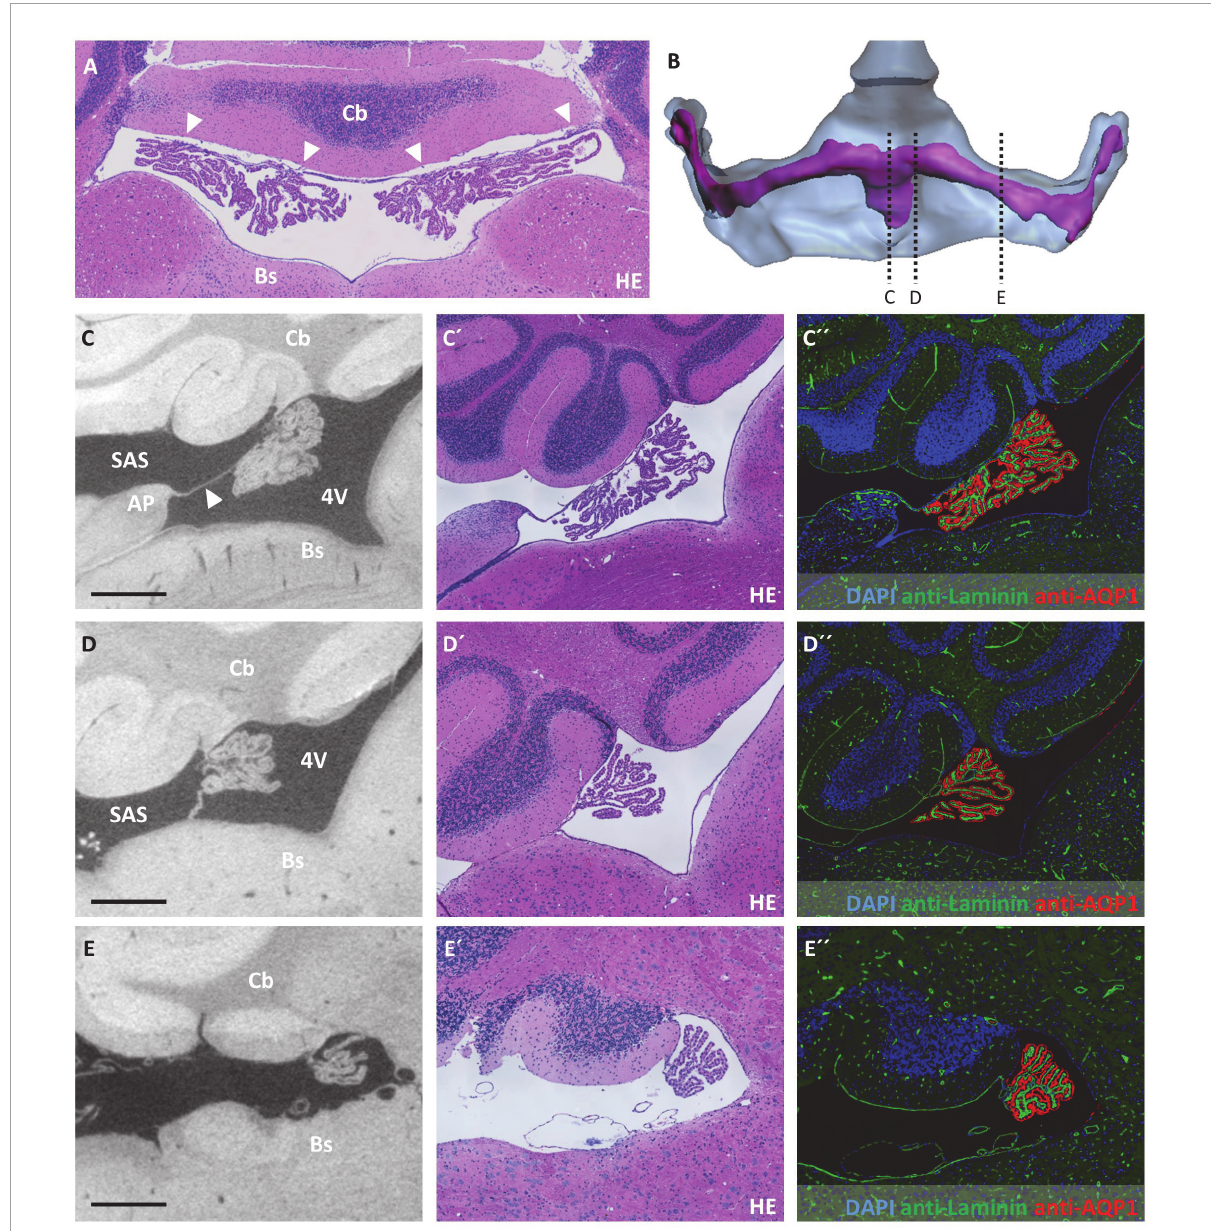
FIGURE5 Attachment regions of the choroid plexus in the fourth ventricle and opening of the fourth ventricle to the subarachnoid space. (A) Horizontal section of the fourth ventricle after hematoxylin-eosin staining, the broad attachment zone of the choroid plexus toward the cerebellum is marked by arrowheads. (B) Illustration of sectional planes in three-dimensional reconstruction of the fourth ventricle (blue) and the choroid plexus (purple) in a dorsal view. (C–E) On the left, virtual sections from micro-computed tomography scan; in the middle, hematoxylin-eosin staining; and on the right, immunofluorescence double labeling with anti-laminin (green), anti-aquaporin1 (AQP1, red), and nuclear staining with 4 (cid:48) ,6-diamidino-2-phenylindole (DAPI, blue). (C–C”) Fourth ventricle in median sectional plane in sagittal orientation, the choroid plexus is attached to the cerebellum and connected to the area postrema of the brainstem by a delicate tissue bridge (arrowhead); (D–D”) fourth ventricle in paramedian sectional plane in sagittal orientation, attachment of choroid plexus to cerebellum and brainstem; (E–E”) fourth ventricle in sagittal sectional plane, attachment of choroid plexus to the cerebellum and opening of the fourth ventricle toward the subarachnoid space. Scale bars in (C–E) 200 µ m. 4V, fourth ventricle; AP, area postrema; Bs, brain stem; Cb, cerebellum; SAS, subarachnoid